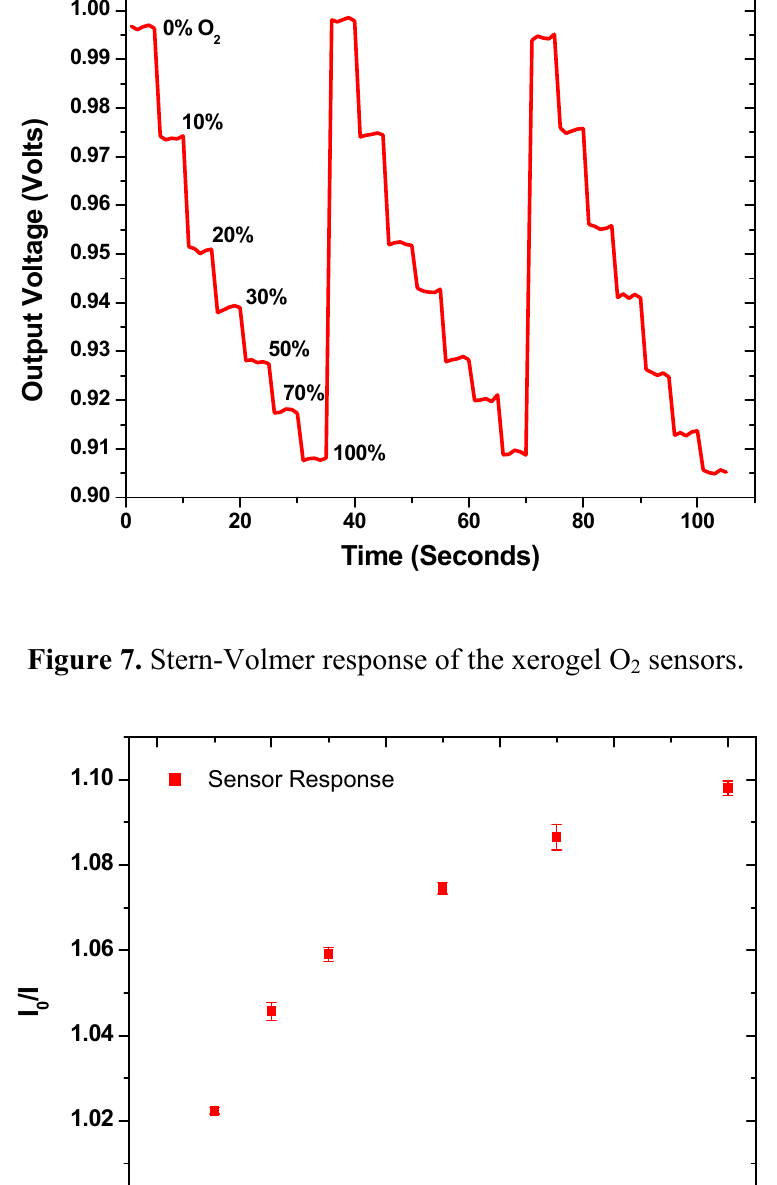
Figure 6. Response of the O